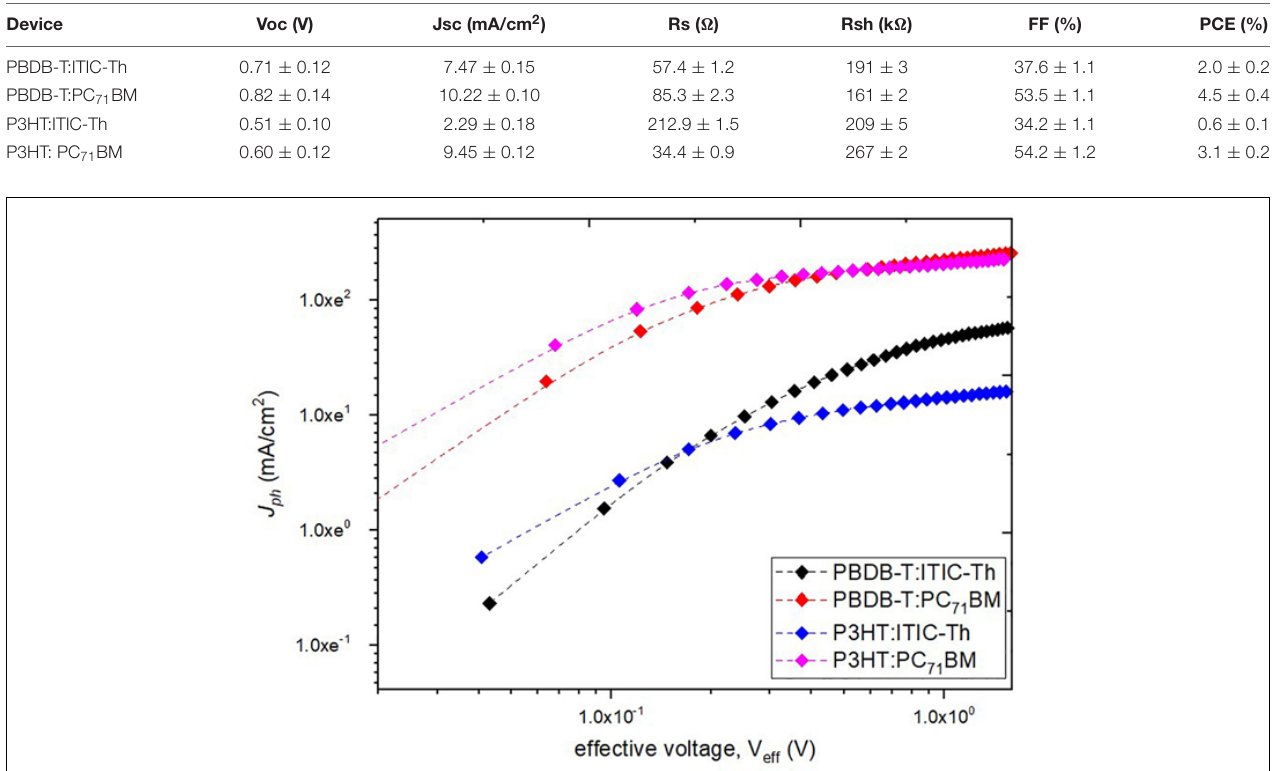
FIGURE 7 | Photocurrent density versus effective voltage curves of solar cells based on different blends.